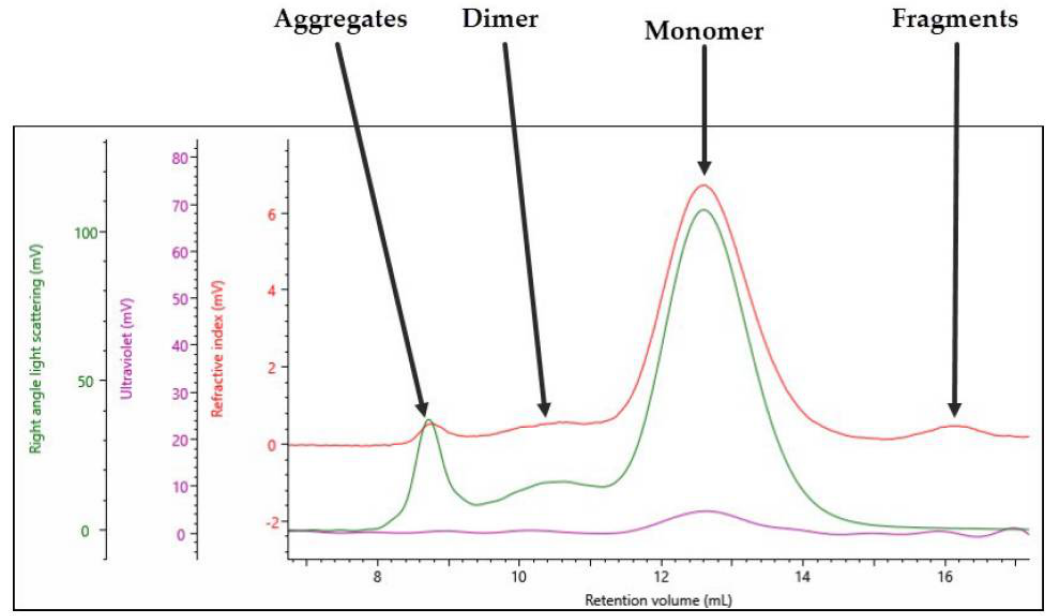
Figure 1. Triple detection chromatogram of rAAV5 (Empty). Red = RI; purple = UV 260 nm; green = RALS. Table 2. Quantitative parameters for rAAV5